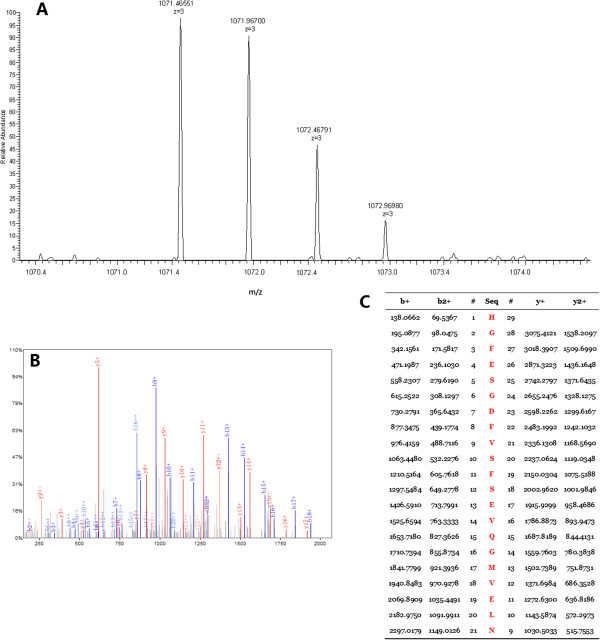
MS/MS map of peptide with MW of 3216.57 Da. (A) The enlarged picture of peptide with MW of 3216.57 Da. (B) The b and y ions spectra used to identify the peptide with MW of 3216.57 Da. (C) The sequence of the peptide with MW of 3216.57 Da.